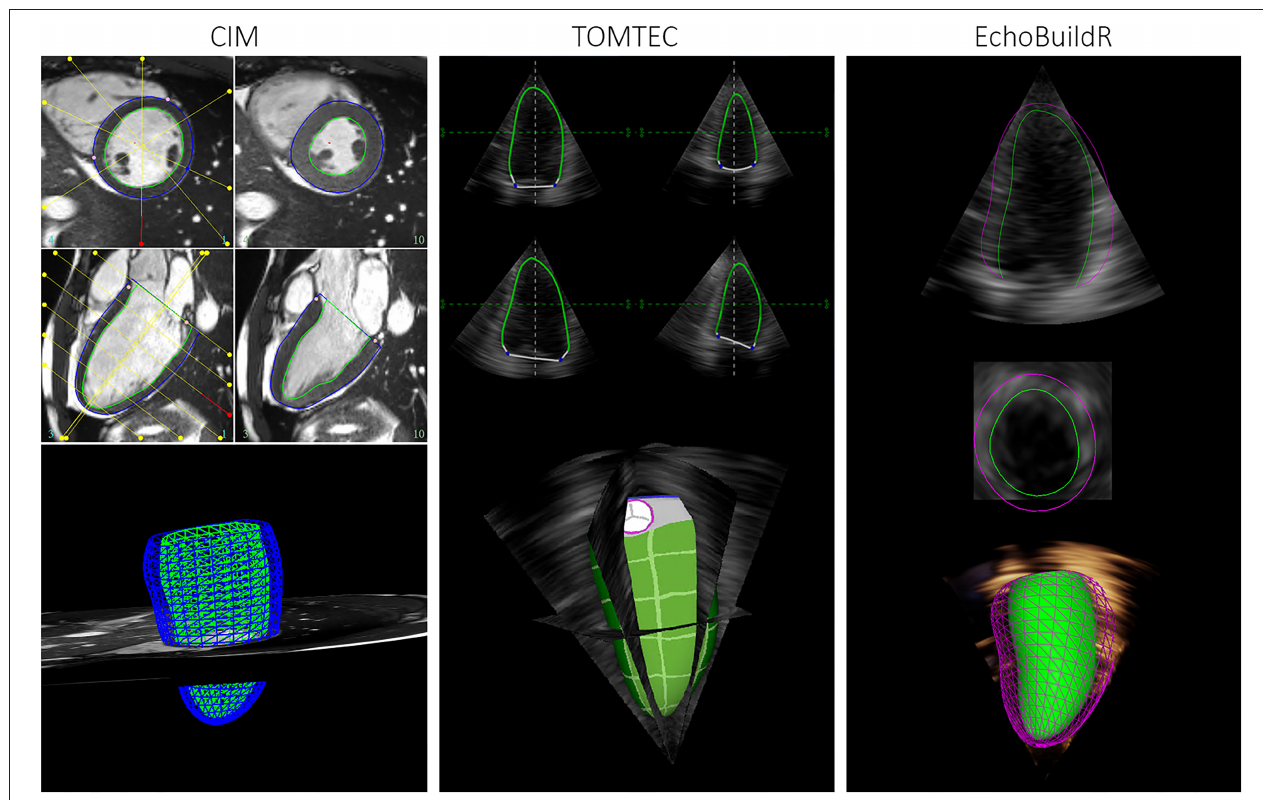
FIGURE 1 | Graphical user interface for semi-automatic construction of LV geometries in CIM (left) , TOMTEC (middle) , and EchoBuildR (right) . (Note that dynamic epicardial modeling was not supported in